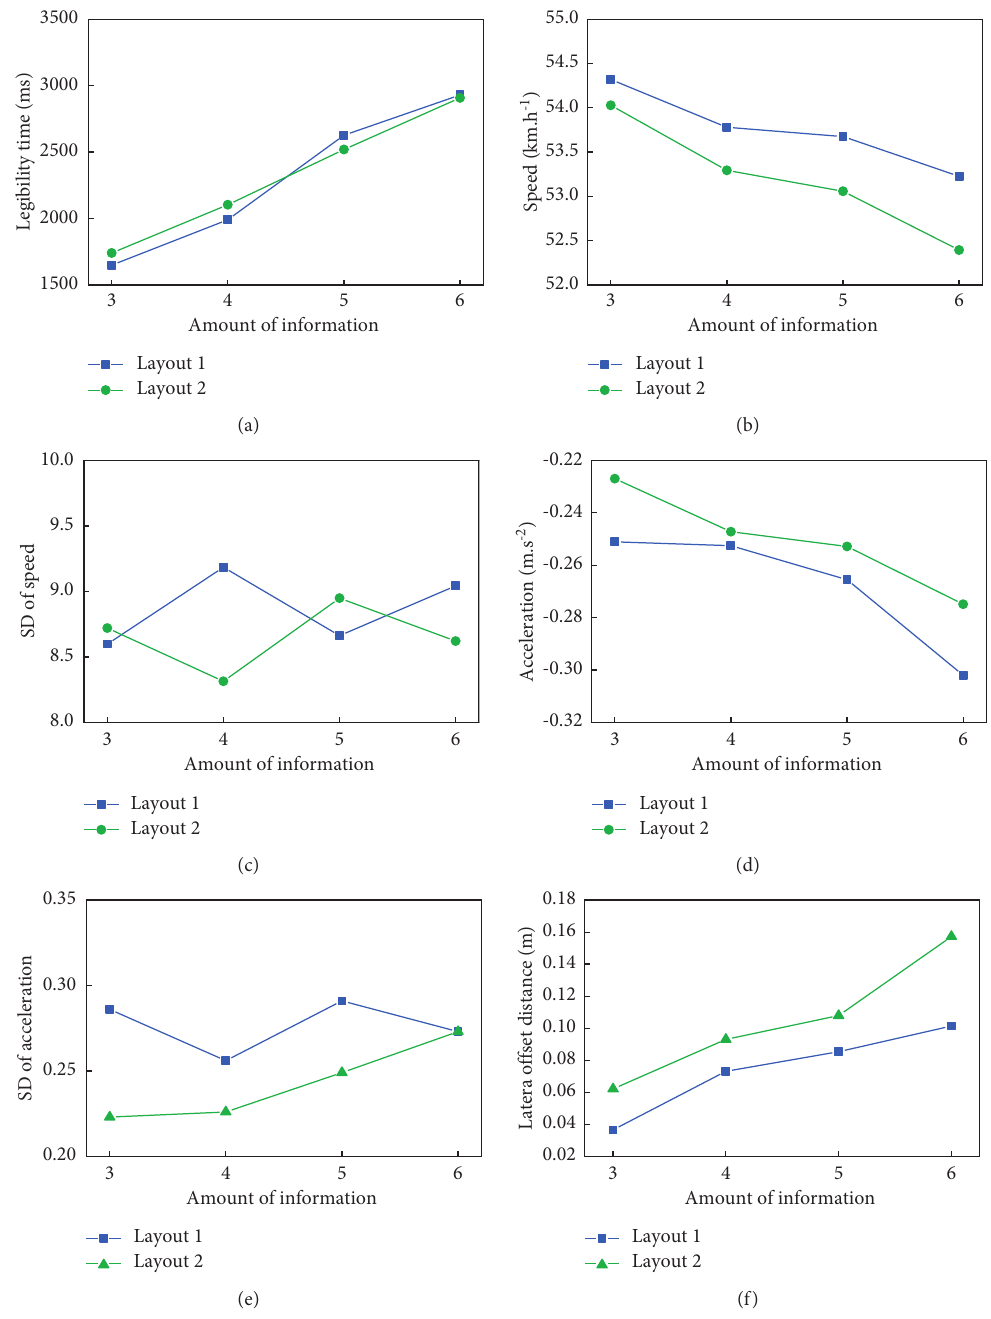
Figure 5: The influence of different guide signs on evaluation indicators: (a) legibility time, (b) speed, (c) SD of vehicle speed, (d) ac- celeration, (e) SD of acceleration, and (f) lateral offset